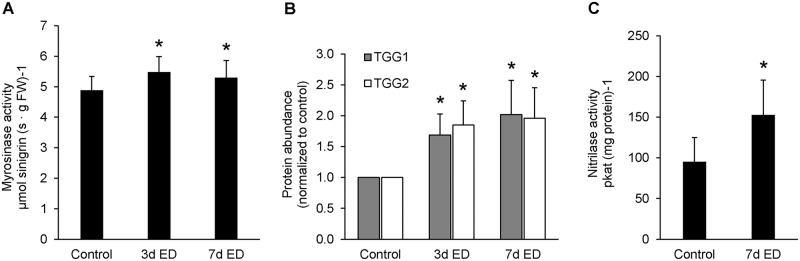
Myrosinase activity, myrosinase protein abundance and nitrilase activity in rosette leaves after extended darkness (ED).The plants were transferred to complete darkness for 3 d (3d ED) or 7 d (7d ED) after six weeks of growth under short day conditions. Myrosinase (A) as well as nitrilase (C) activity was measured photometrically (error bars show the standard deviation of five to 19 biological replicates). For protein abundance of TGG1 and TGG2 (B), immunoblotting and normalization to the control was performed (error bars represent the standard deviation of three biological replicates from three independently performed Western blots). Asterics indicate significant differences (Student’s T-test; P < 0.05) compared to the control.